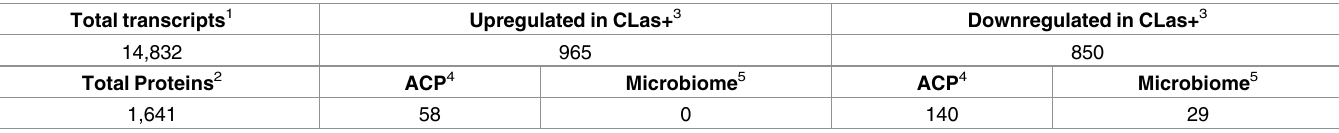
1 Number of transcripts identified by RNA sequencingwith more than one count per million in three or more replicates 2 Number of proteins identified using proteomics with a minimum of two unique peptides 3 Number of transcripts or proteins with a p value of < 0.05 after a Wald/exact test (transcripts) or Fisher’s exact test (proteins) and with a CLas+/CLas- Log fold change of ± 0.5 4 Proteins matching to the Diaphorina citri proteome